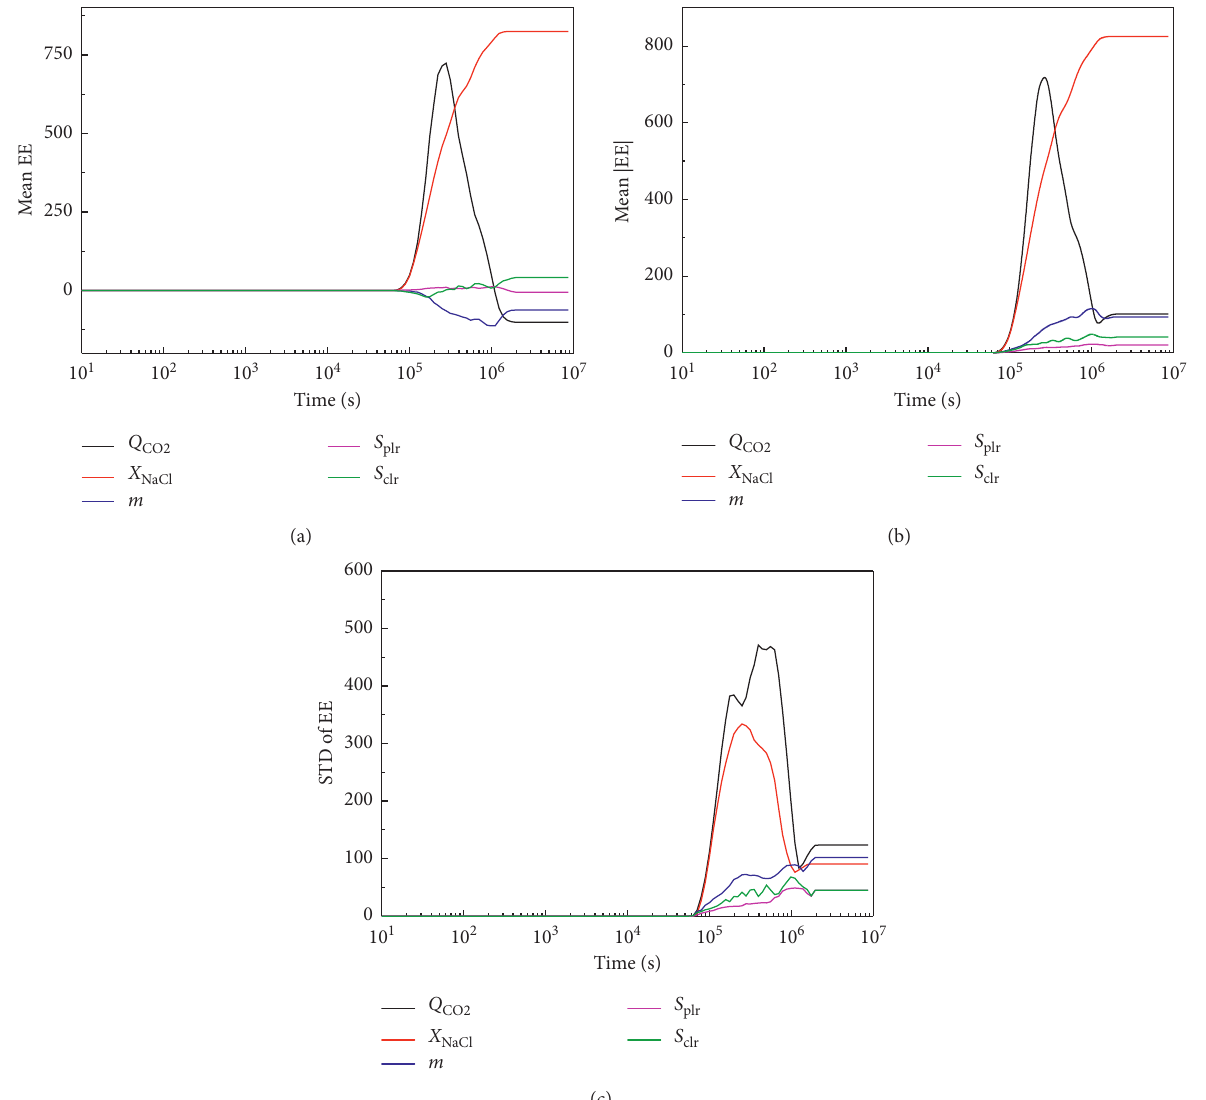
Figure 9: Time evolution of the Morris sensitivity index: (a) mean EE; (b) mean |EE|; (c) STD of EE.